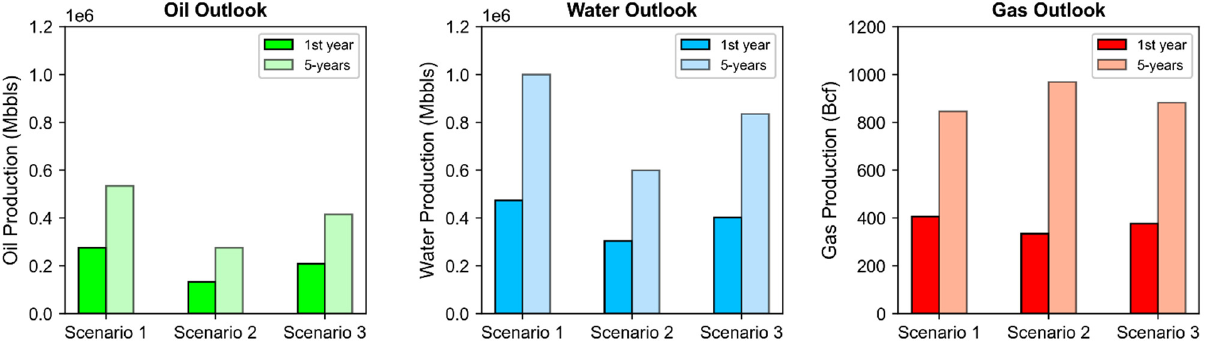
Figure 14. Oil, water, and gas production volumes under three different development scenarios for the Midland Basin. Each scenario assumes 1842 new wells drilled and completed.